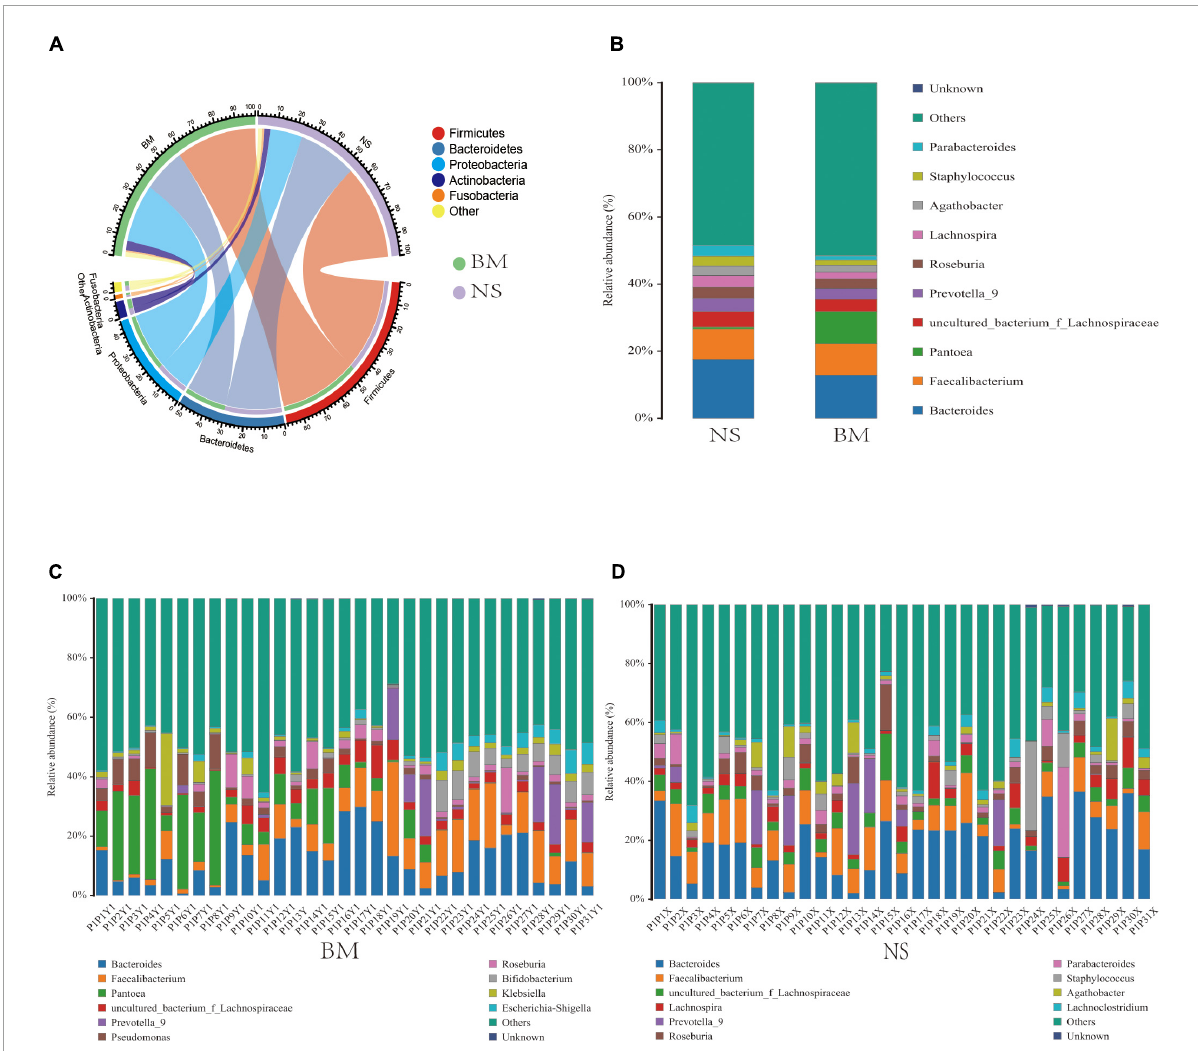
FIGURE2 The common (A,B) and unique (C,D) relative abundances of predominant microbiota taxa in BM and NS. The common microbiota at the panels (A) phylum level and (B) genus level. The unique microbiota at the genus level of panels (C) BM and (D) NS. The proportion of microbial abundance was more than 0.1%, and the top 10 were